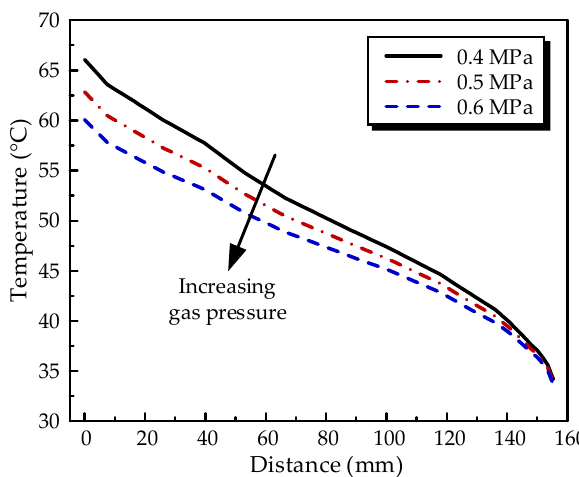
Figure 11. Surface temperature distribution along the spacer surface with different SF 6 pressures.